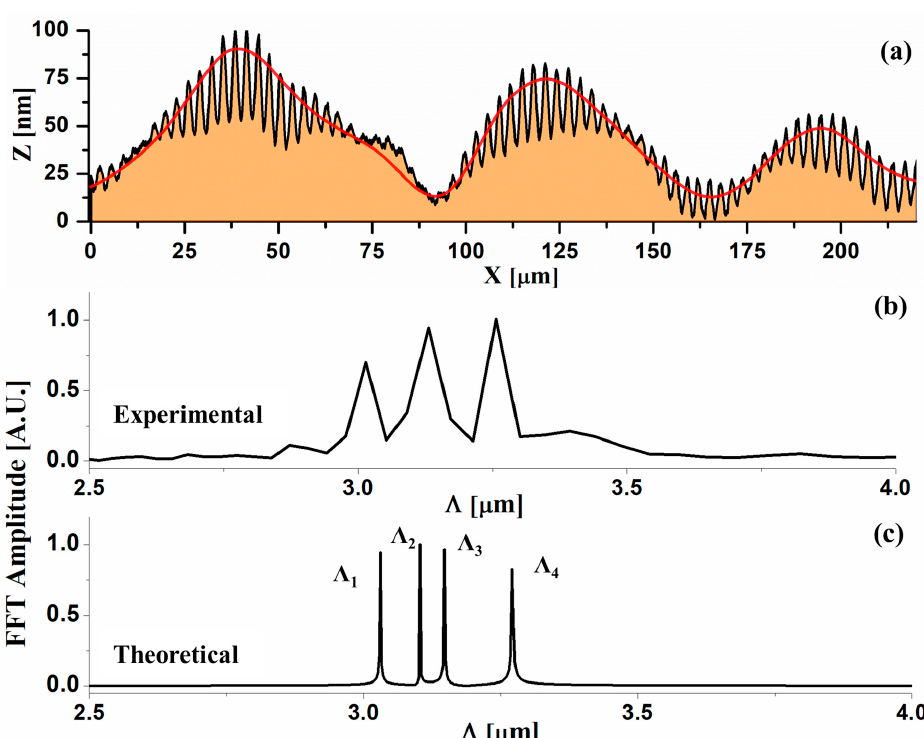
5 Figure 5. ( a ) Surface profile of the PDR1Ma thin film after the exposure to the multiline interference pattern. The profile, acquired by profilometer, is superimposed with its envelope (red line) to better highlight the large-scale modulation. Experimental ( b ) and theoretical ( c ) Fast Fourier transform derived from the surface profile in ( a ) and the intensity profile in Figure 3d,